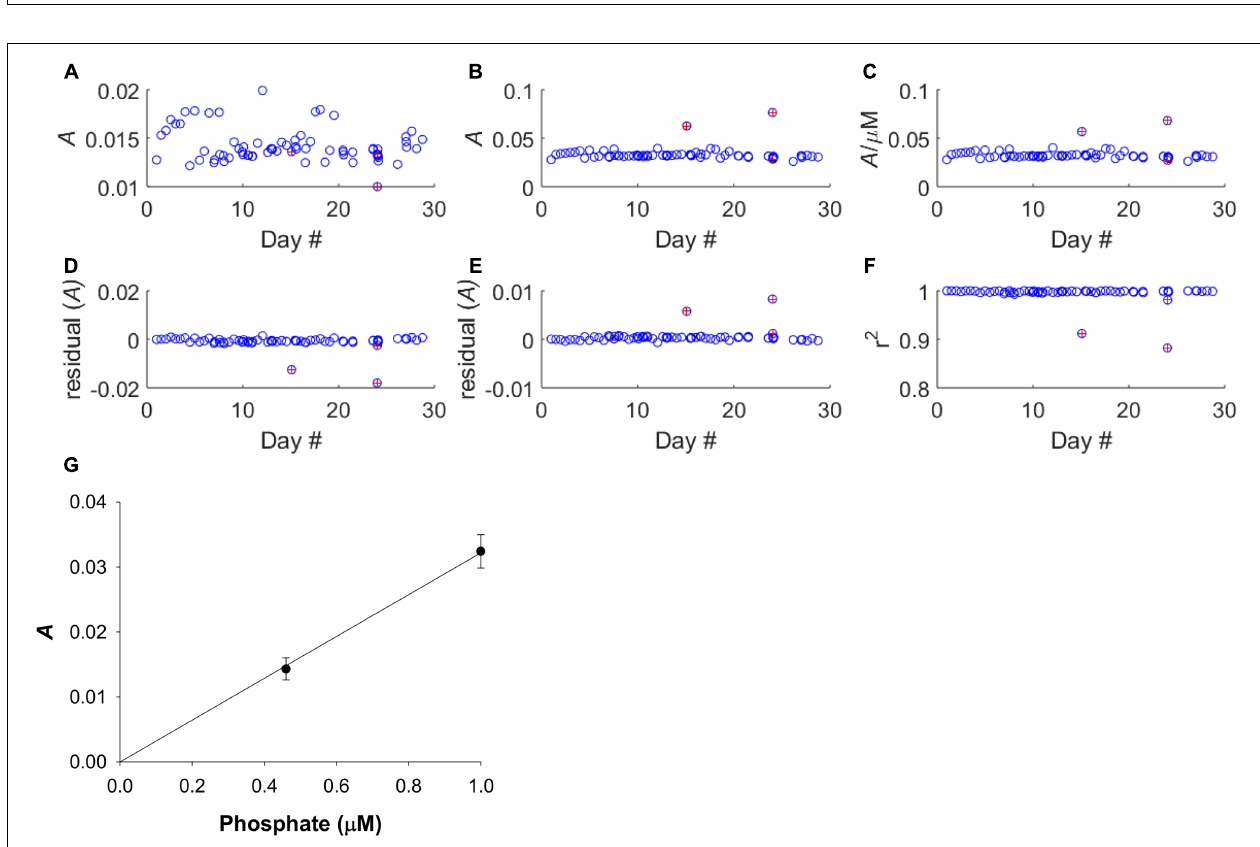
FIGURE 4 | Calibration performance of LoC analyser throughout the deployment. Red markers indicate poor calibrations and data from these dives was removed before further analyses. (A) The absorbance of the 0.46 µ M standard. (B) The absorbance of the 1.00 µ M standard. (C) Sensitivity of analyser. (D) Residual values for 0.46 µ M standard. (E) Residual values for 1.00 µ M standard. (F) Correlation co-efficient of regression slope. (G) Average calibration slope for all deployment dives, except those with poor calibrations, with linear fit forced through the zero intercept. The linear fit was based on a mean 0.46 µ M PO 43 − standard absorbance of 0.0143 ± 0.0017, and a mean 1.00 µ M PO 43 − standard absorbance of 0.0324 ± 0.0026. The mean regression slope was 0.0322 ± 0.0027.